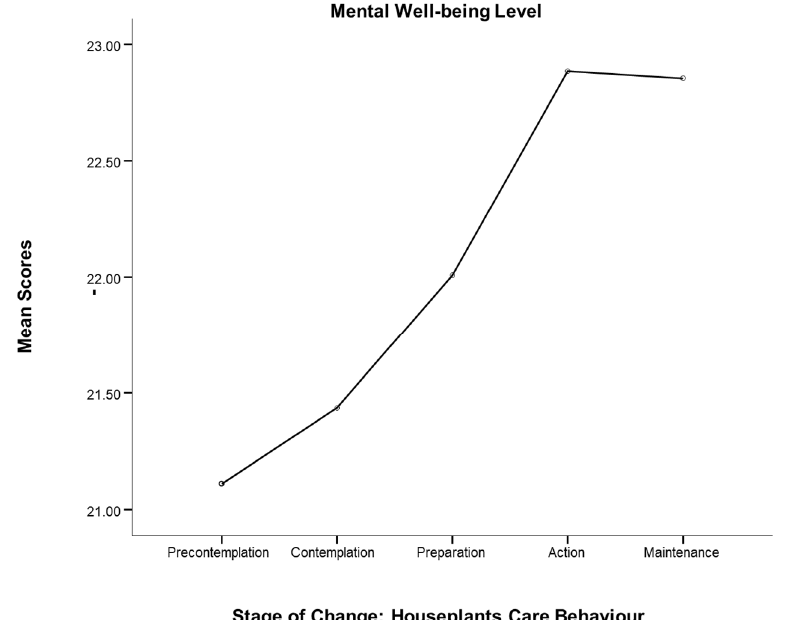
Figure 3. Houseplants care behaviour and mental well-being.